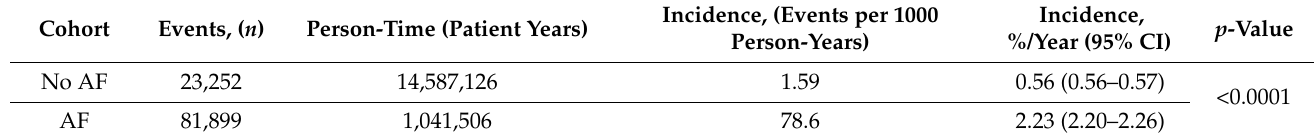
Table 2. Incidence of VT/VF/CA.